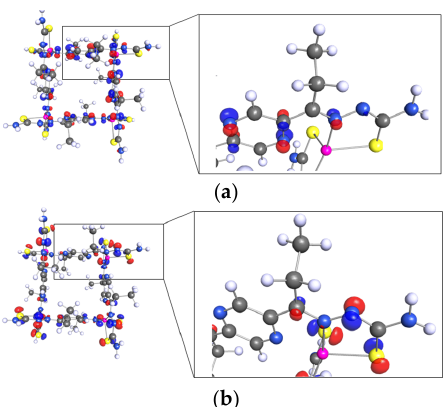
Figure 7. DFT (RI-)BP86/def2-TZVP calculated LUMO ( a ) and HOMO ( b ) of [Zn 4 (L Et ) 4 Figure 7. DFT (RI ‐ )BP86/def2 ‐ TZVP calculated LUMO ( a ) and HOMO ( b ) of [Zn 4 (L Et ) 4 ].